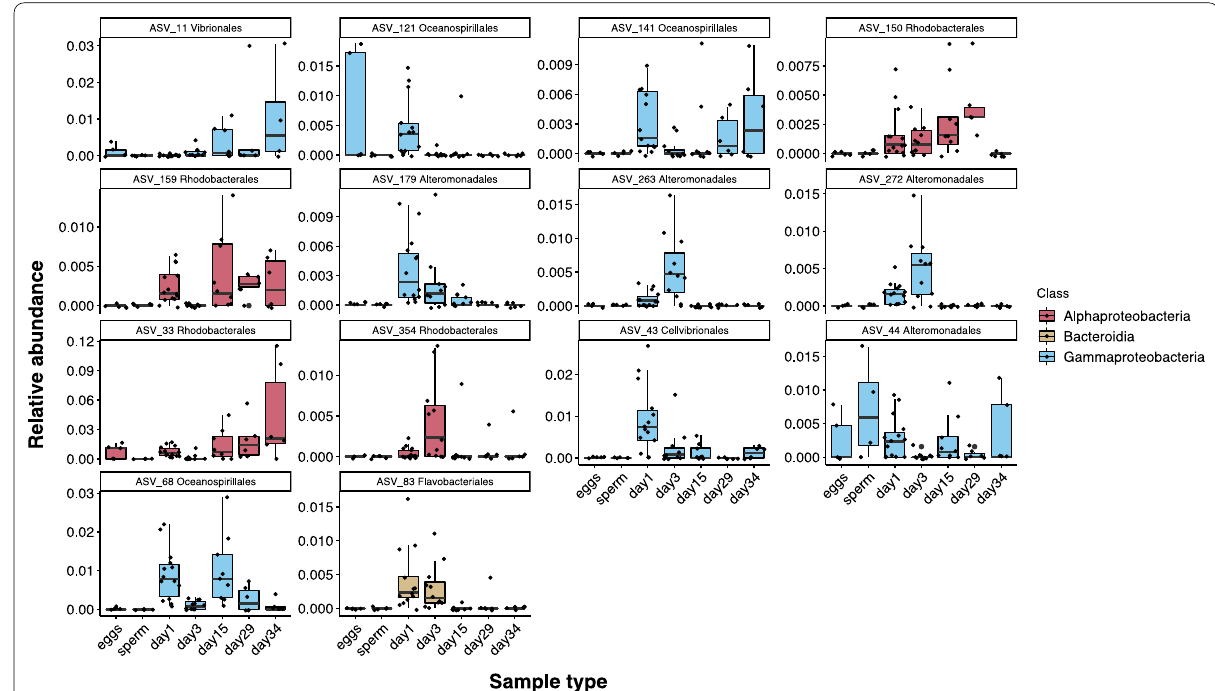
Fig. 5 Box and whisker plots of the relative abundances of ASVs identified as core members (present at greater than 1% abundance in more than 50% of samples) in the eggs, sperm, and all larval stages. This analysis excluded all ASVs detected in tank water and algae samples with a relative abundance greater than 1%. More detailed taxonomic information can be found in Additional file 1: Table